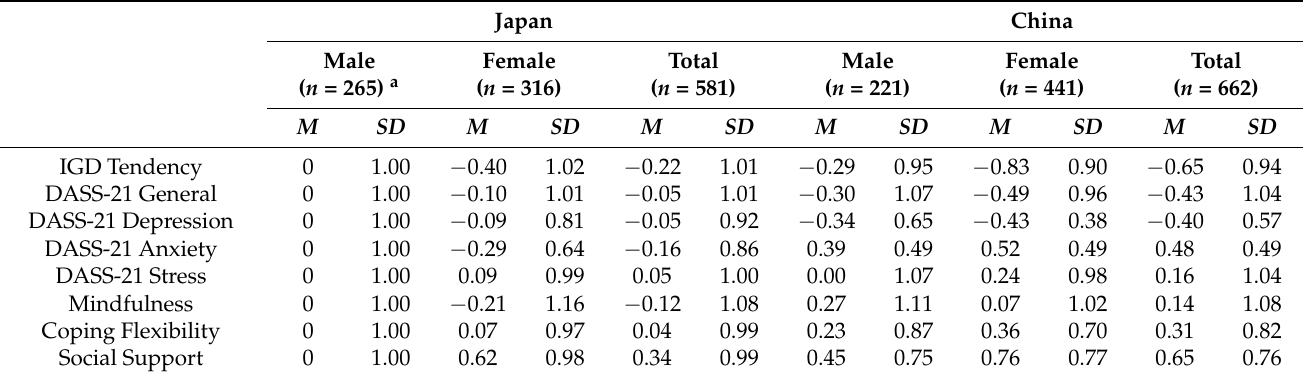
Table 1. Means (age-adjusted) and standard deviations and comparison of the major variables in Model